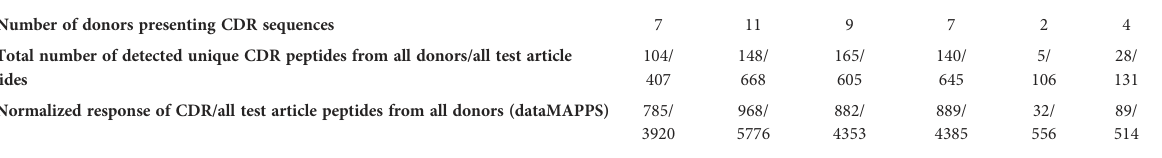
TABLE 1 CDR sequences from TNF antagonists presented by the HLAII.